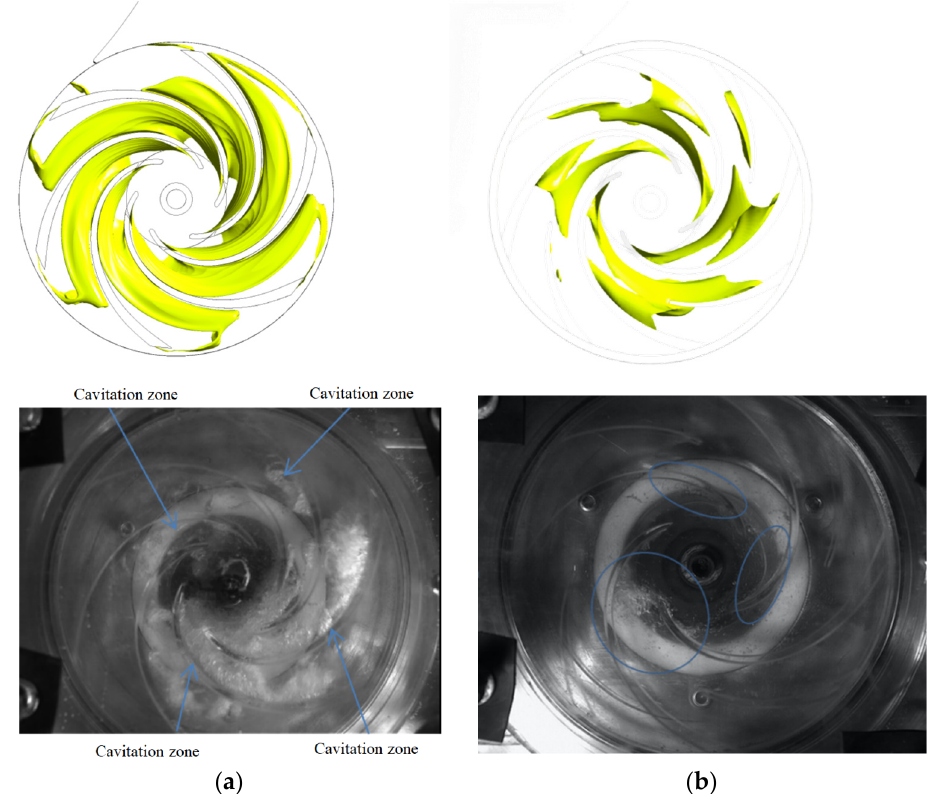
Figure 9. Cavitation zones in both cylindrical and splitter blades at σ = 0.04. ( a ) Cylindrical blades; ( b )Splitter blades.